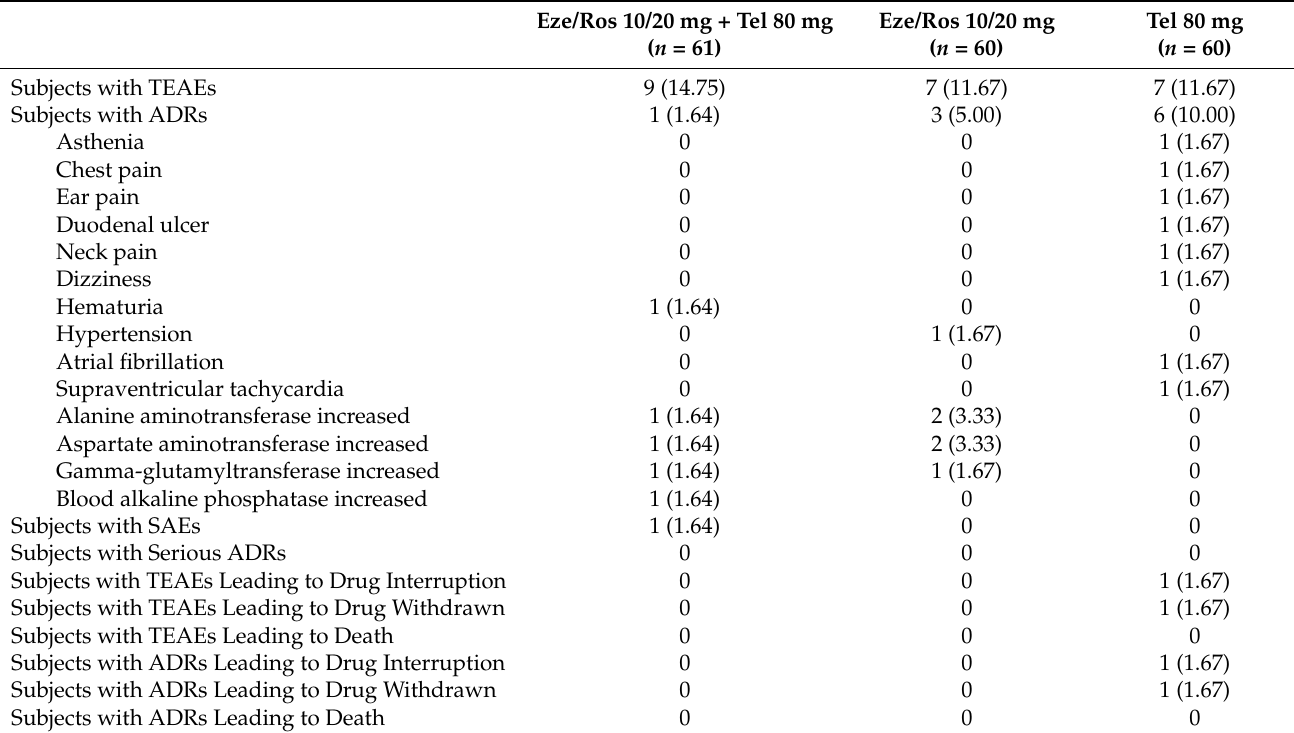
Table 3. Overall summary of TEAEs.